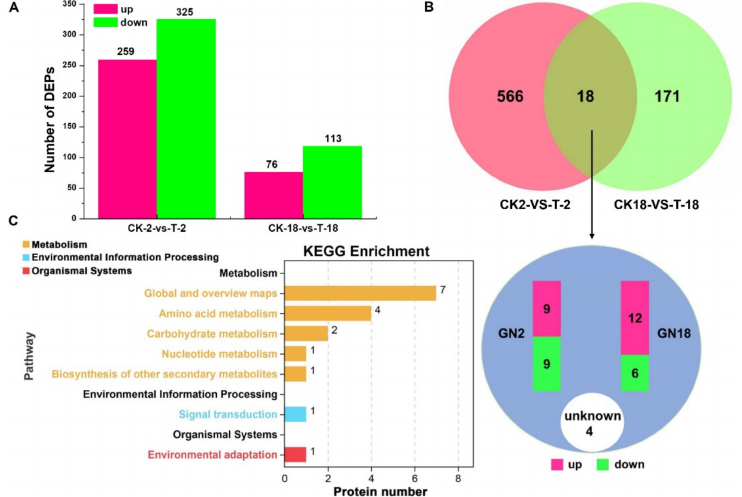
Figure 2. Differentially expressed proteins (DEPs) of different salt-tolerant cultivars in response to salt stress treatments during seed germination. ( A ) Number of DEPs in barley GN2 and GN18. ( B ) Venn diagram analyses of DEPs in seeds. The magnitude of the Rich Factor is positively correlated with the significance of the enrichment. ( C ) Visualization of common differentially abundant proteins between GN2 and GN18 and their KEGG pathway